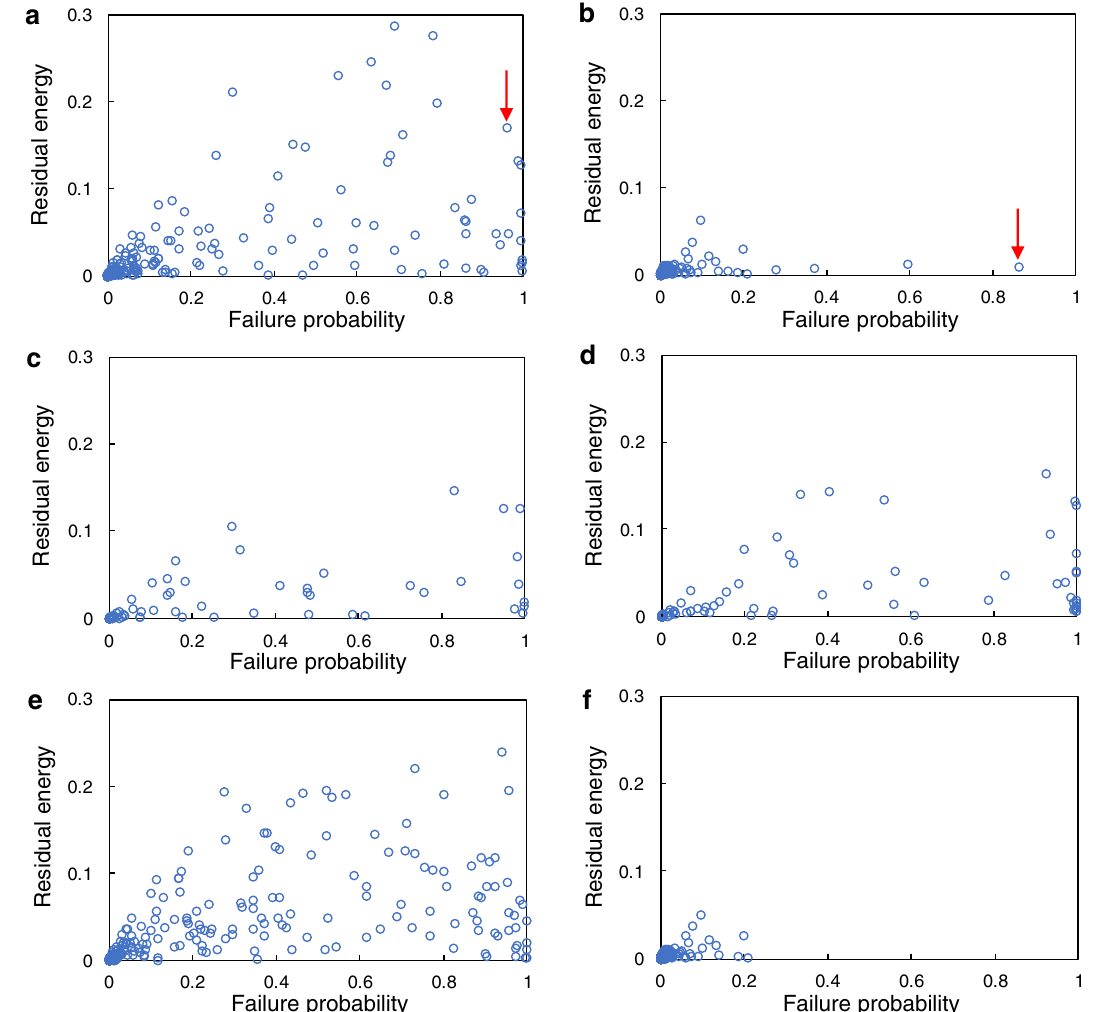
Fig. 2 Comparison among various approaches to quantum annealing in terms of worst instances. We display simulation results for the same 1000 instances as in Fig. 1 as a scatter plot of the residual energy vs the failure probability in order to better appreciate the improvement in performance provided by our proposed approach based on excited-state quantum annealing (QA). a Results for ground-state QA with a network of Kerr-nonlinear parametric oscillators (KPOs). b Results for the proposed approach based on excited-state QA with a KPO network. c Results for fi ve times iteration of the ground- state QA. d Results for ground-state QA with a fi ve times longer computation time. e Results for ground-state QA with control of pump amplitudes to reduce photon-number deviations. f Results obtained by selecting the best result from the results in b and e for each instance. Red vertical arrows in a and b indicate the worst instances obtained by the ground-state QA and the proposed approach, respectively, which are discussed in detail in the main text using Figs. 3 and 5. Overall, the proposed approach based on excited-state QA provides better performance even when compared with enhanced ground- state QA